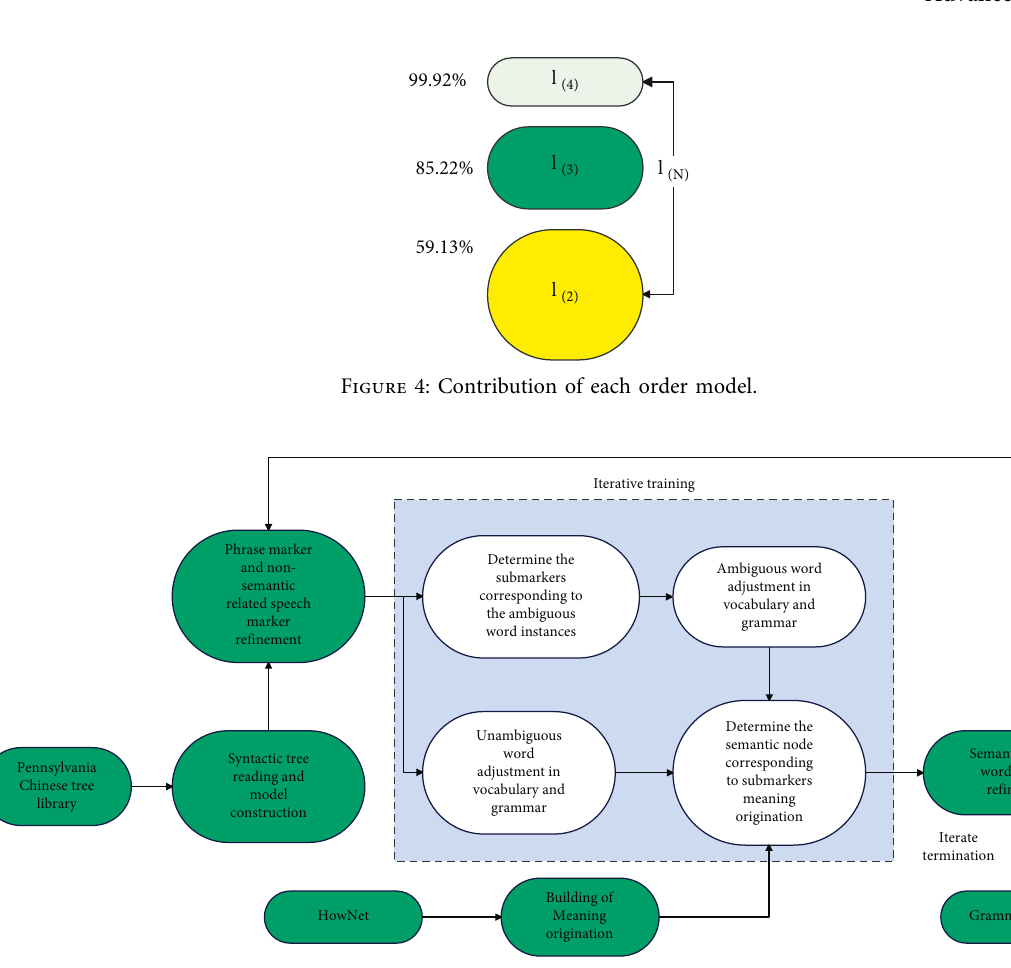
Figure 5: Block diagram of word sense disambiguation in the training process of English syntactic analysis.